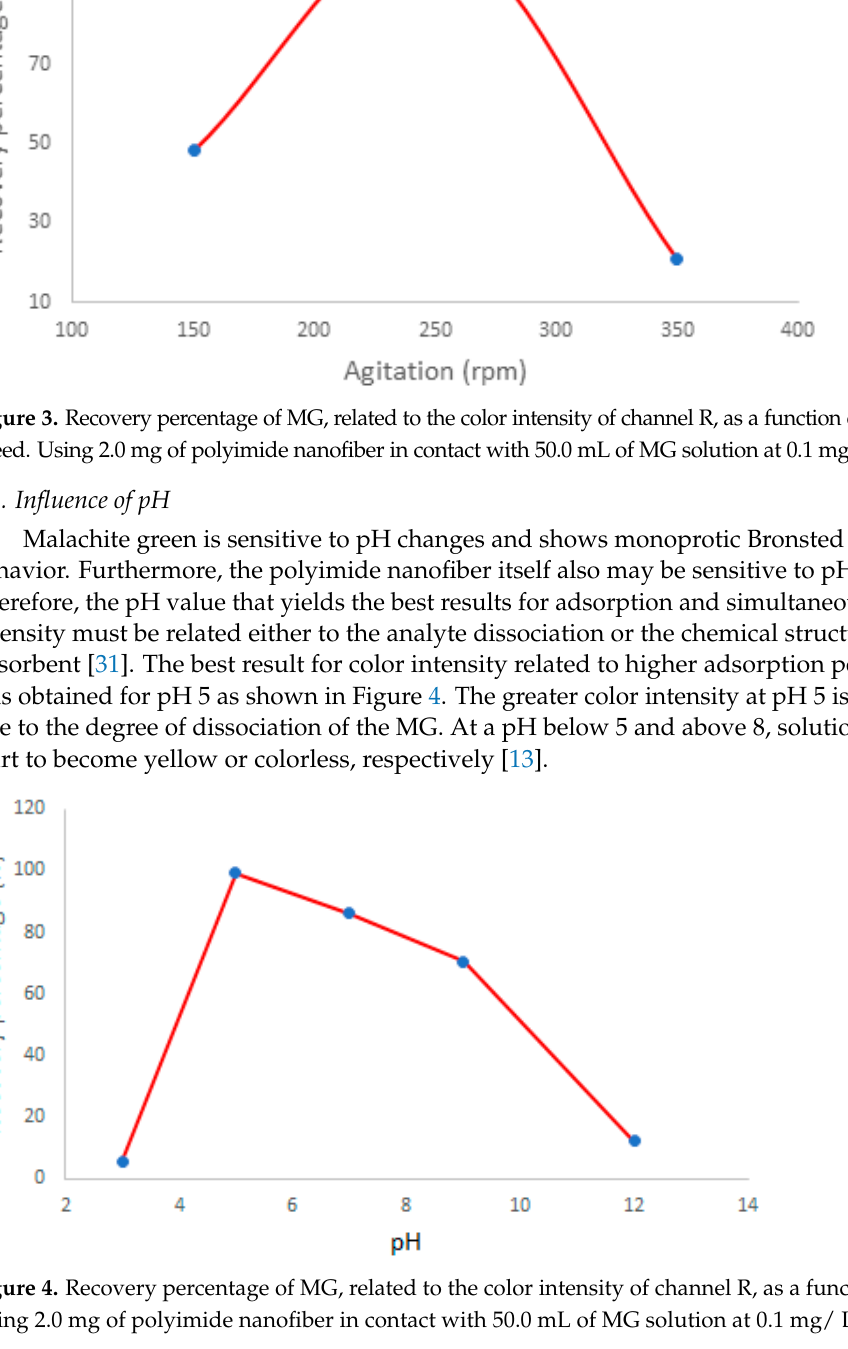
Figure 4. Recovery percentage of MG, related to the color intensity of channel R, as a function of pH. Using 2.0 mg of polyimide nanofiber in contact with 50.0 mL of MG solution at 0.1 mg/ L.